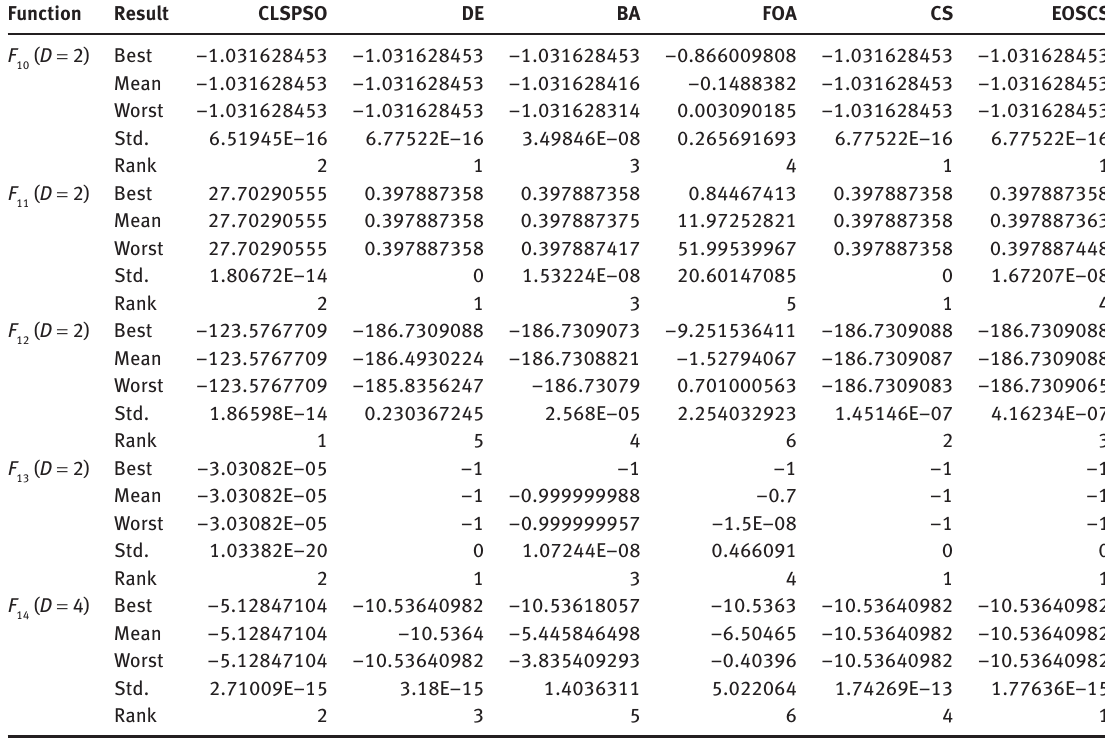
Table 2: Experiment Results of Benchmark Functions for Different Algorithms.